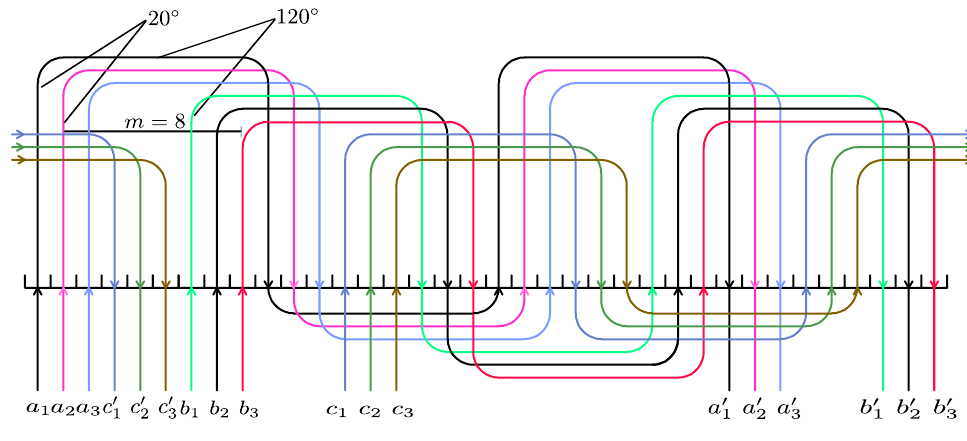
Figure 3. Winding diagram by poles consequent to a single layer for a nine-phase IM with asymmet- rical configuration.